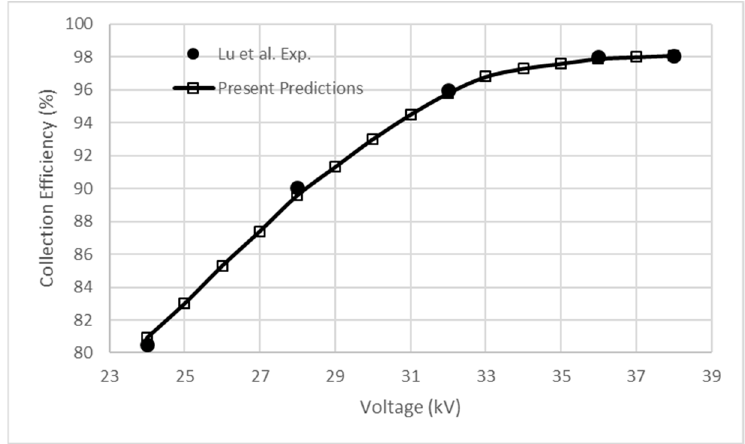
Figure 5. Comparison of collection efficiency values with the experimental data of Lu et al. [9].